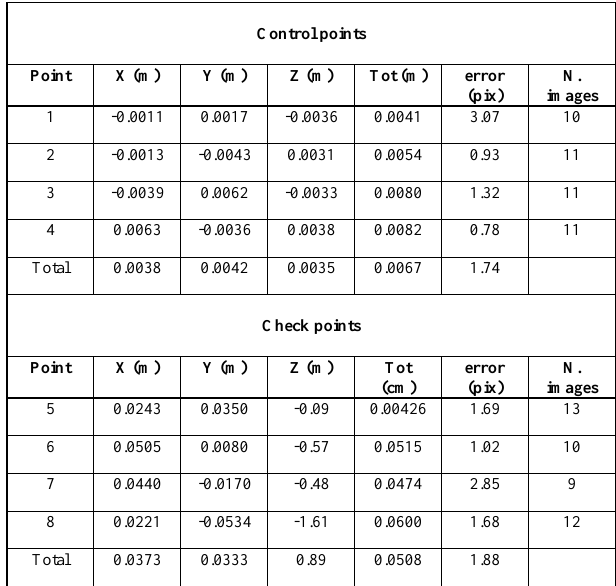
Table 1. Residuals on control points (room 1, points 1-2-3-4) and check points (room 2, points